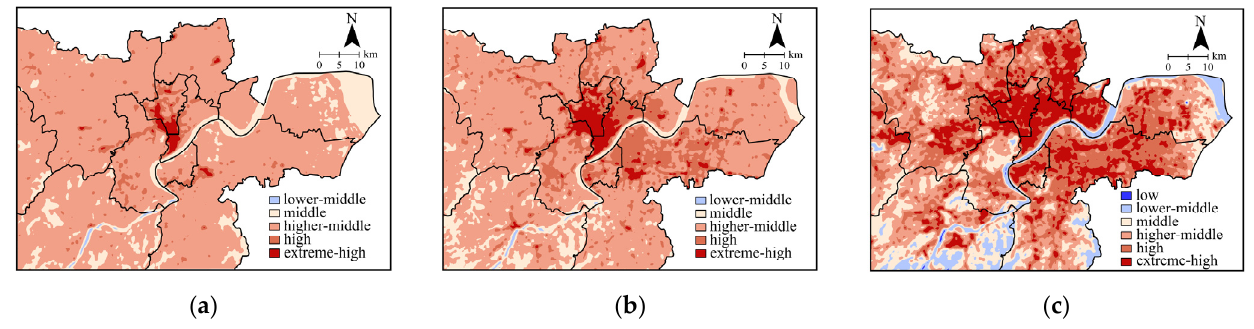
Figure 7. Distribution of Hangzhou’s thermal environment during the three periods in the typical periods: ( a ) 1984; ( b ) 1998; ( c ) 2020.